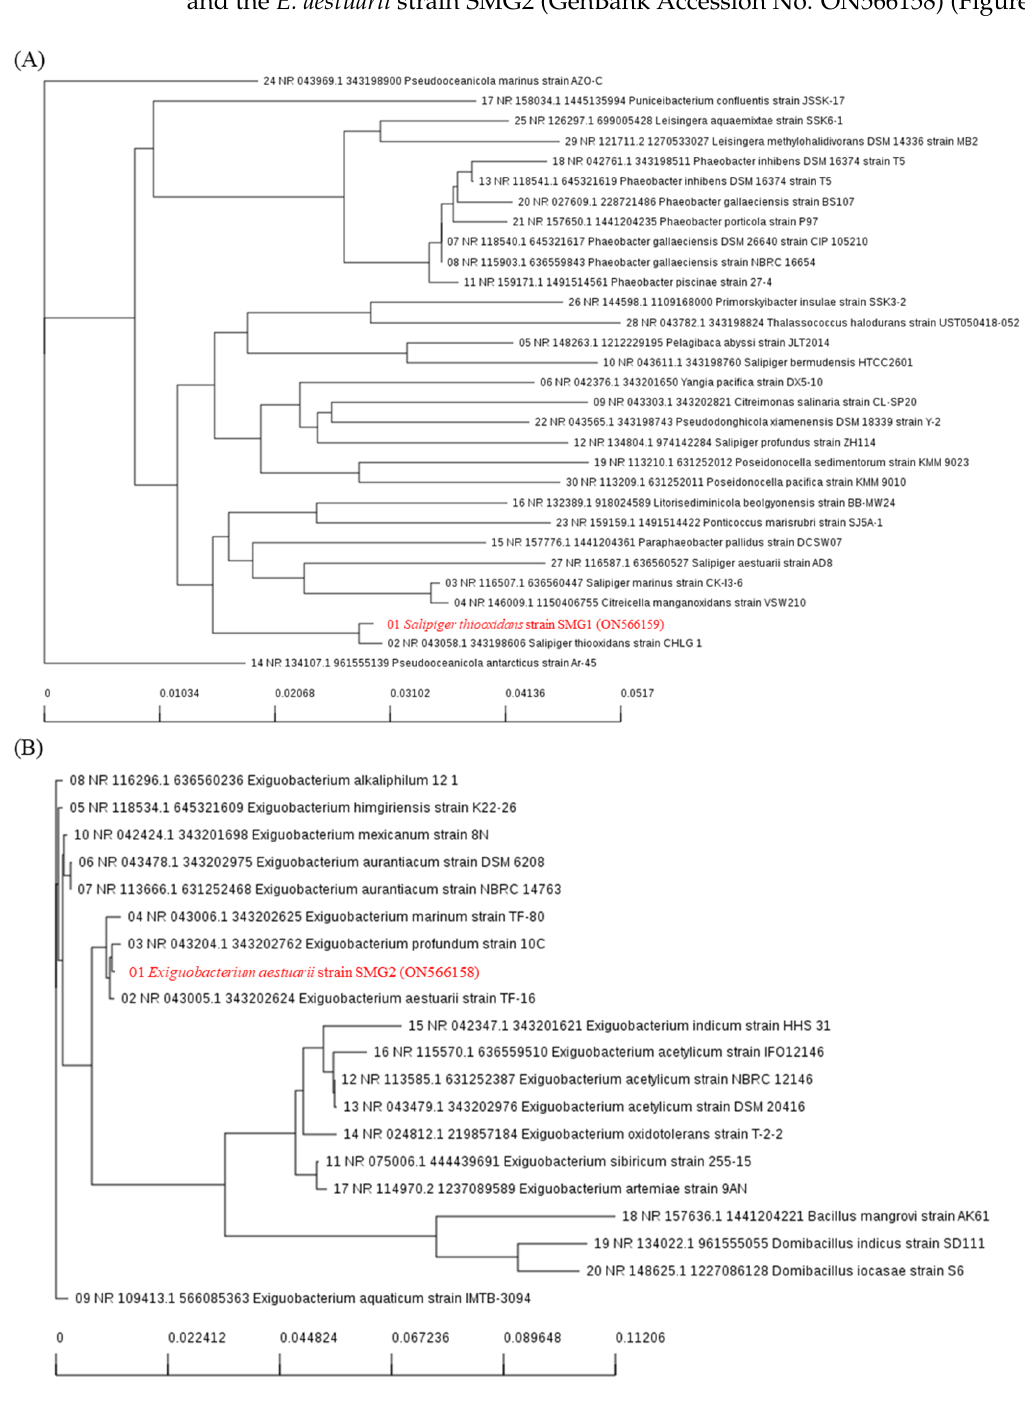
Figure 1. Phylogenetic tree derived from neighbor-joining analysis of partial 16S rRNA gene se- quences of effective microorganisms and their closely related species: ( A ) Salipiger thiooxidans strain SMG1, ( B ) Exiguobacterium aestuarii strain